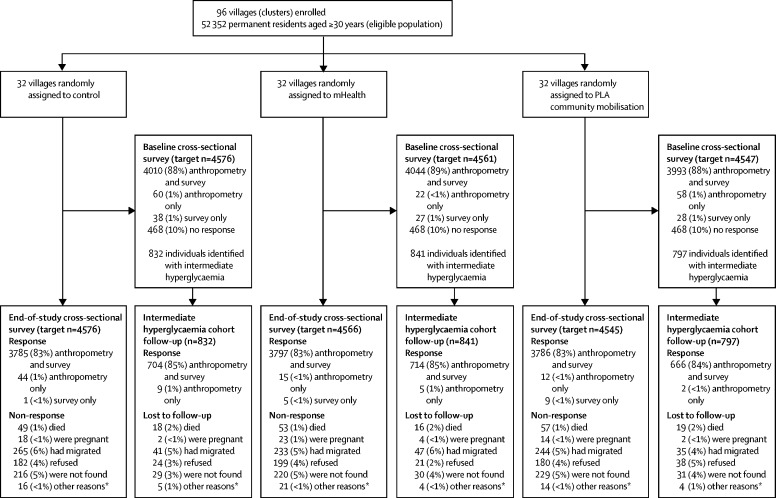
Trial profileAnthropometry includes all physical measures—ie, blood glucose, blood pressure, weight, height, and waist and hip circumferences. PLA=participatory learning and action. *Other reasons were physical or mental disability or severe illness preventing participation, incarceration, or temporary residence only.